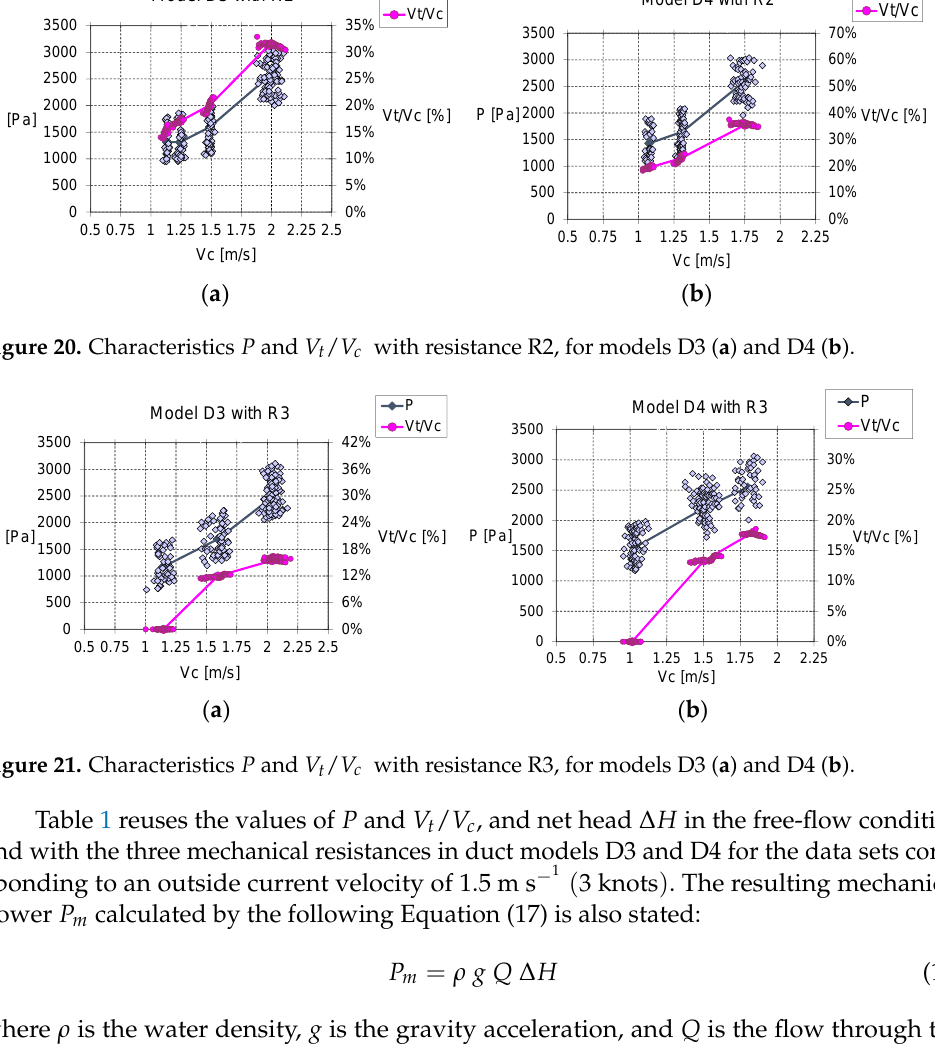
Table 1. The effects of 𝑃 , 𝑉 𝑡 /𝑉 𝑐 , ∆𝐻 , and 𝑃 𝑚 on free-flow and partial obstruction for Models D3 and D4, with 𝑉 𝑐 = 1.5 m s − 1 .